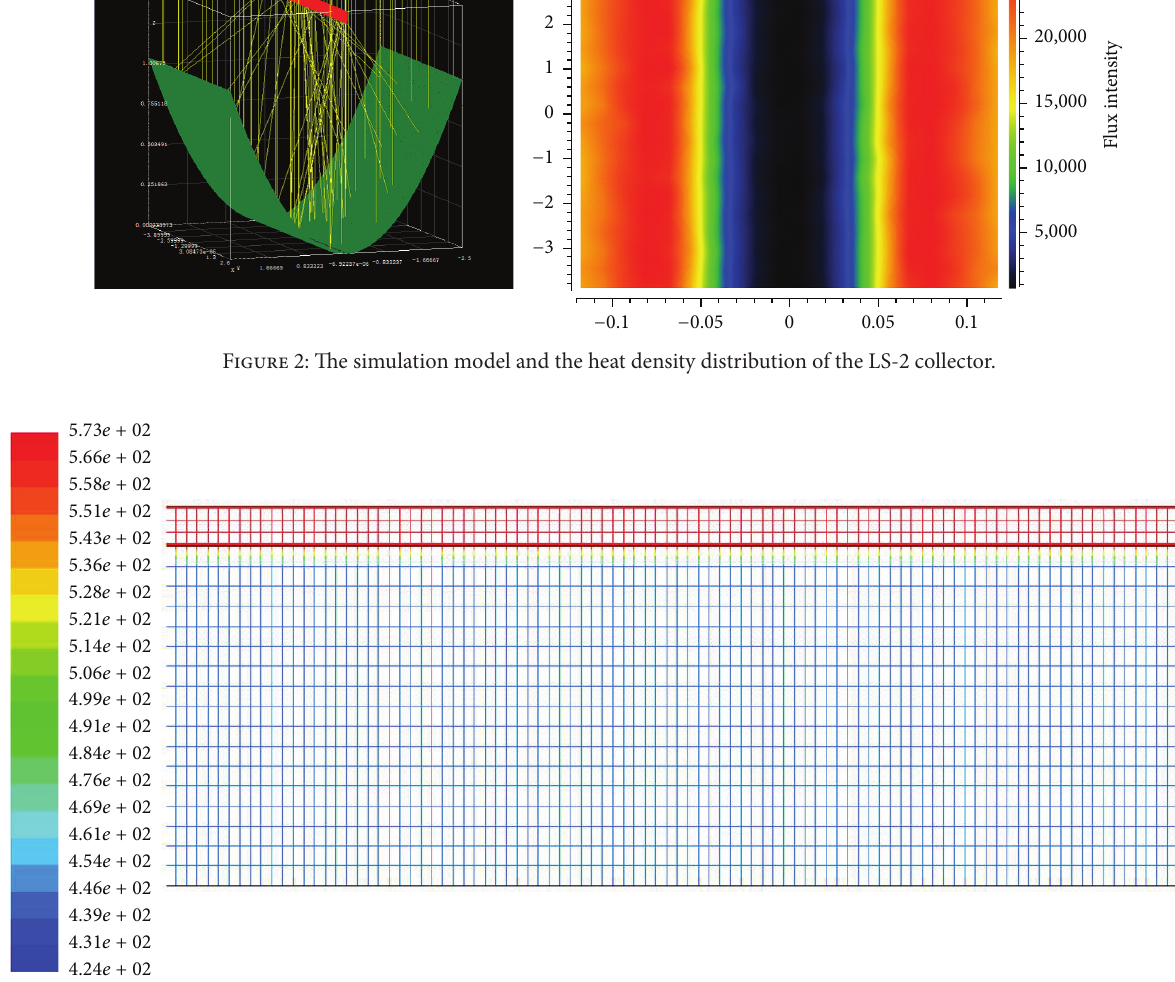
Figure 3: The temperature cloud of the receiver